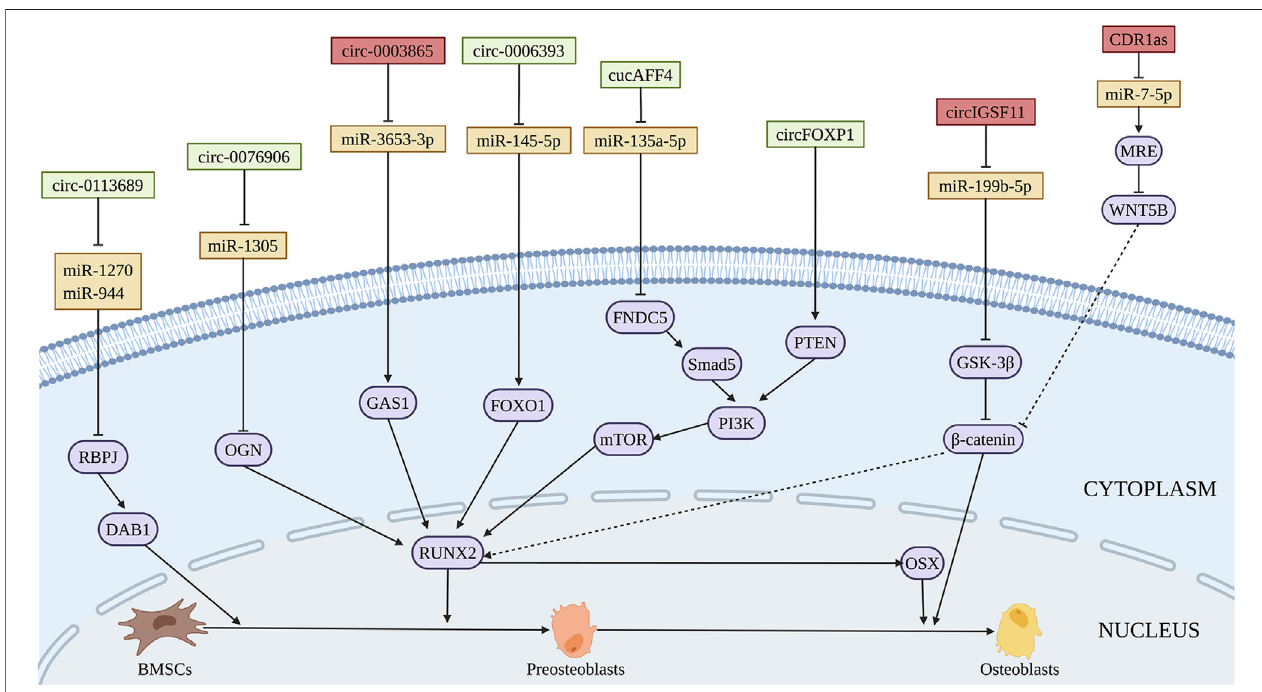
FIGURE 6 | Illustration of the role and regulatory mechanism of circRNAs-promoted (green) and inhibited (red) osteogenic differentiation of BMSCs. Some circRNAs inhibit BMSCs osteogenesis through sponging pro-osteogenic miRNAs (orange). (Created with BioRender.com).